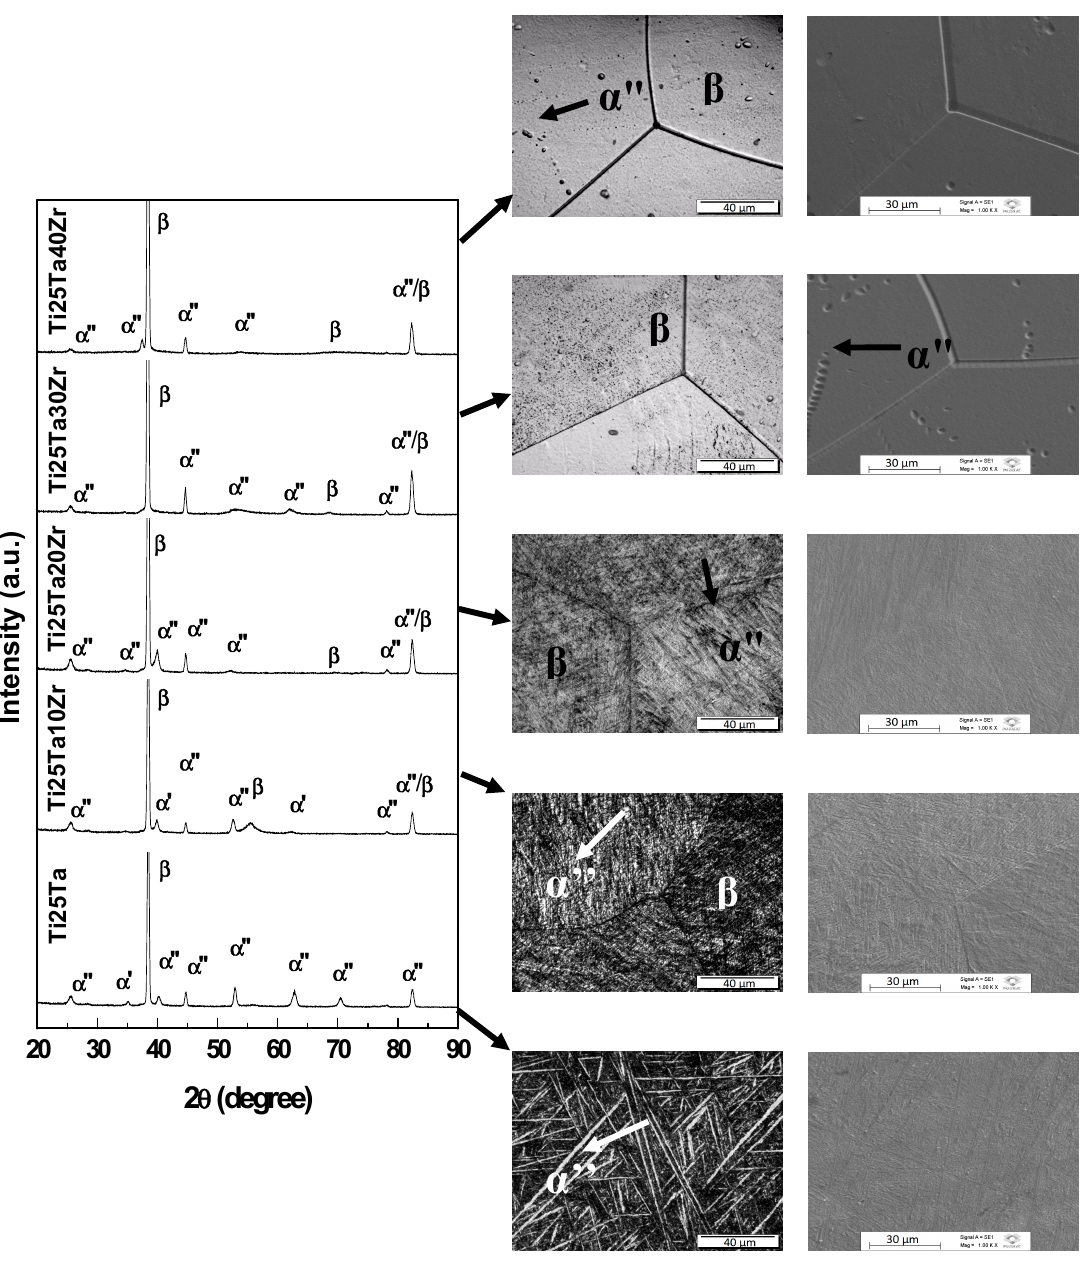
Figure 3. X-ray di ff raction patterns and optical and SEM micrographs for Ti-25Ta-xZr system alloys Figure 3. X-ray diffraction patterns and optical and SEM micrographs for Ti-25Ta-xZr system alloys after annealing heat treatment with rapid after annealing heat treatment with rapid cooling.